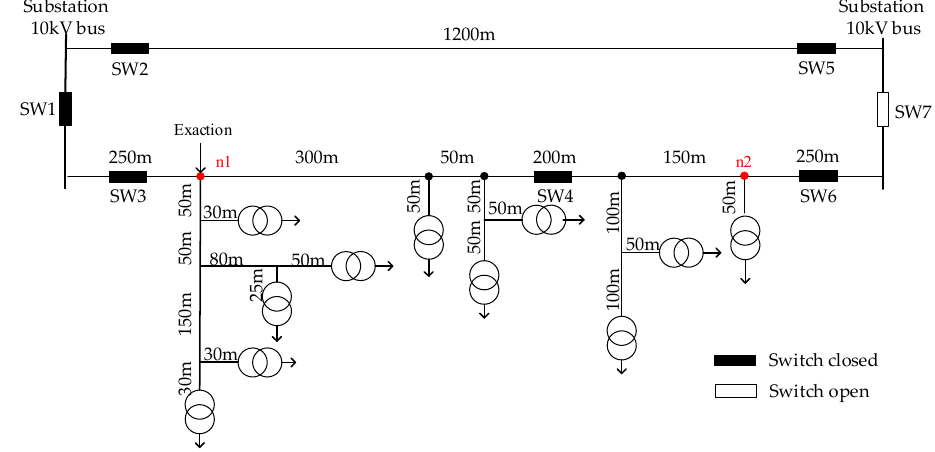
Figure 8. Example of the ring distribution network.